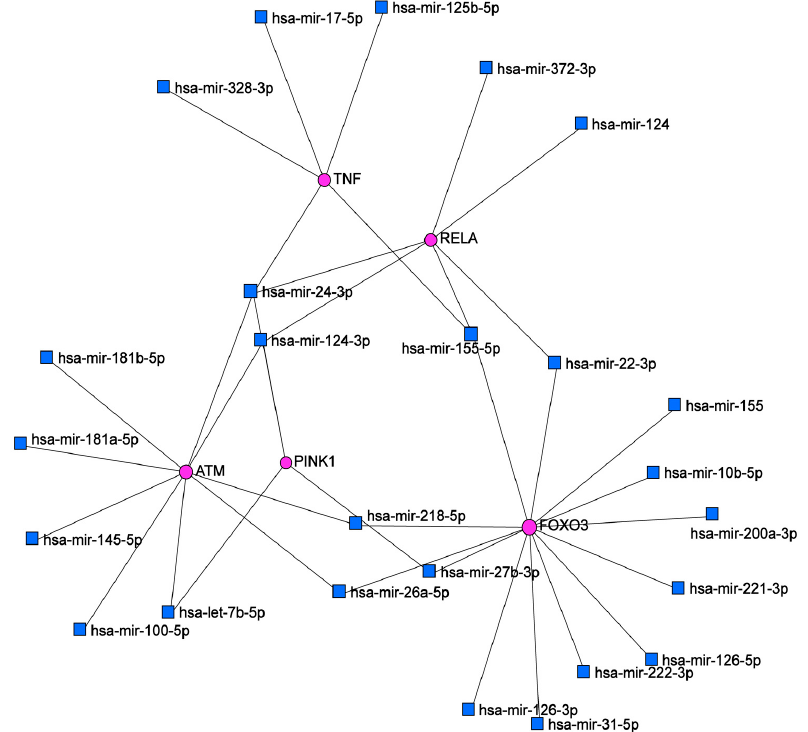
Figure 7. miRNA-mRNA interaction network with differentially expressed genes in the skin, con- structed using miRNet database data. Table 2. Top miRNAs and targeted mRNAs in the network interactions determined via miRNet.